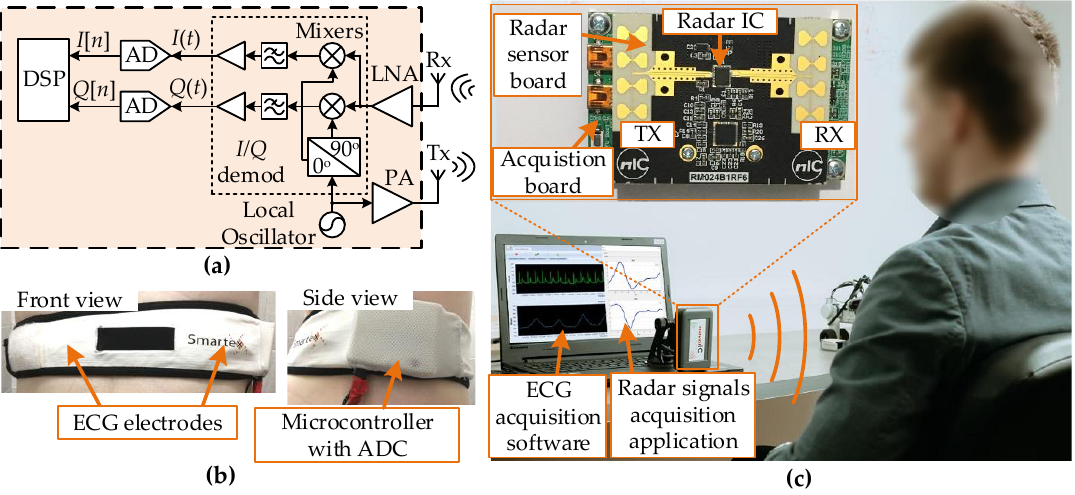
Figure 1. ( a ) Architecture of the quadrature Doppler radar used for the measurements; ( b ) Photographs of the Smartex Wearable Wellness System (WWS) used for the electrocardiogram (ECG) measurement; ( c ) Experiment setup.